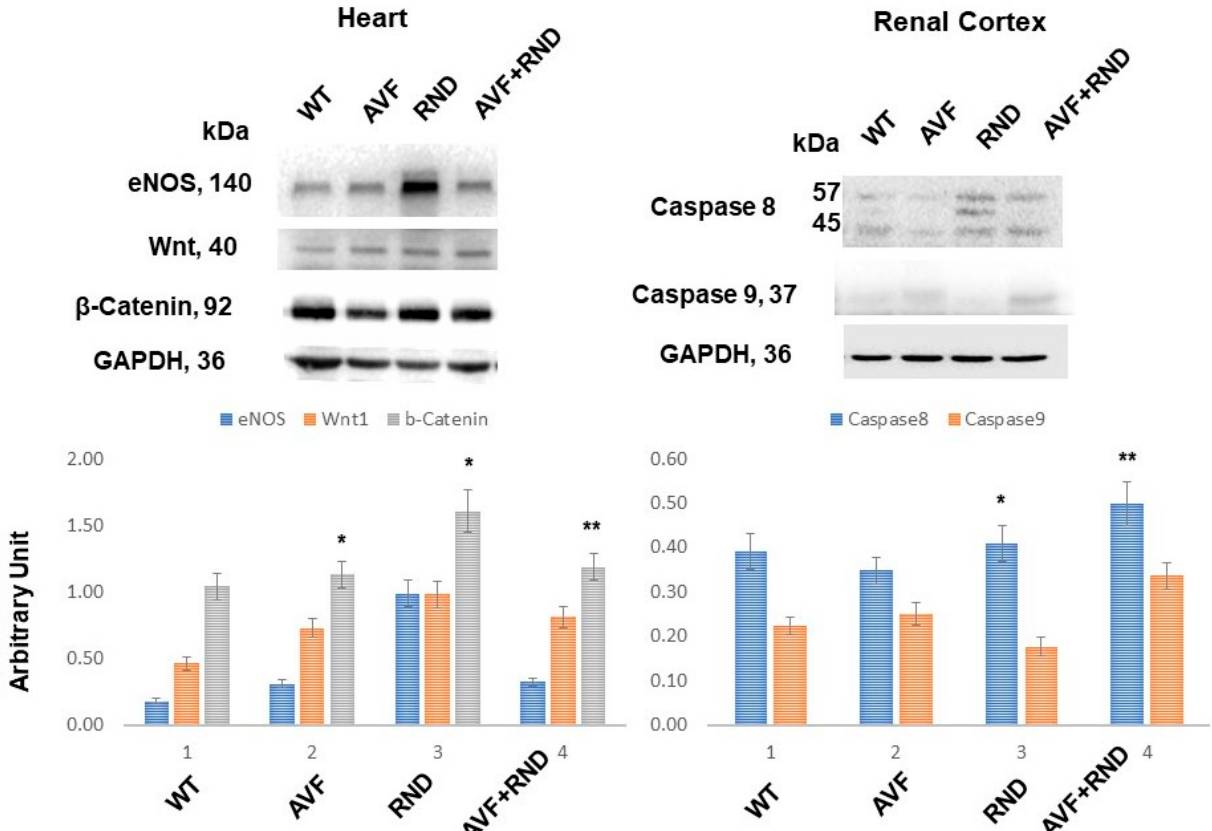
Figure 2. Representative Western blotting analyses of the cardiac tissue for endothelial nitric oxide synthase (eNOS), wingless-related integration (wnt1), and β -catenin signaling pathway molecules and from the renal-cortex tissues for caspase 8 and − 9 in samples obtained from C57BL/6J WT-control mice, AVF, RND, and AVF-RND male mice at 16 weeks. The bar graphs represent the mean ± SD from n = 5; *, p < 0.05 compared to WT; **, p < 0.05 compared with AVF.